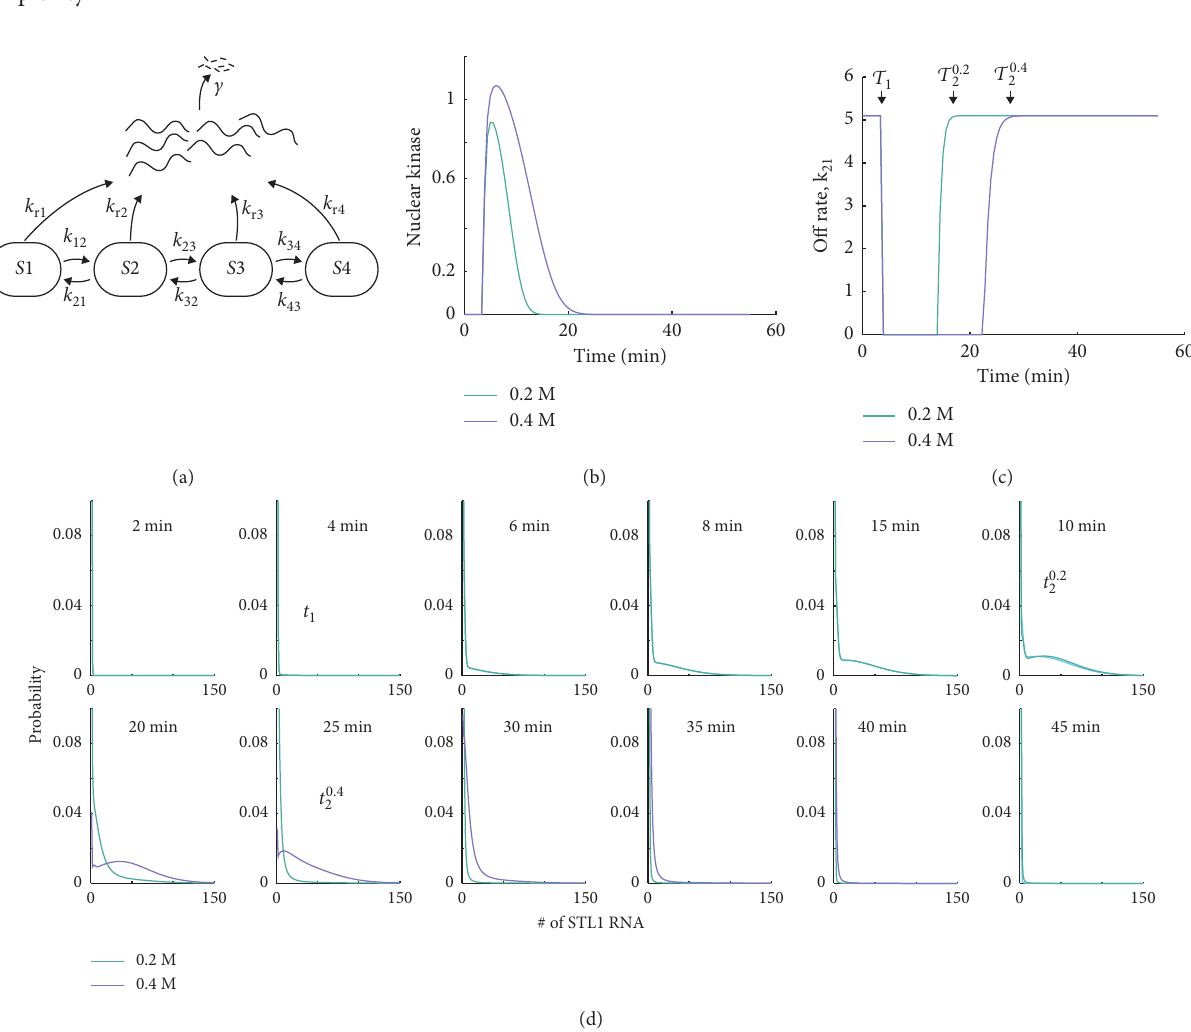
Figure 1: Stochastic modeling of osmotic stress response genes in yeast. (a) Four-state model of gene expression, where each state transcribes mRNA at a different transcription rate, but each mRNA degrades at a single rate c . (b) Time-varying MAPK nuclear localization signal. (c) The rate of switching from gene activation state S2 to S1 (right) under 0.2 M or 0.4 M NaCl osmotic stress. The time at which k 21 turns off is denoted with τ 1 and is independent of the NaCl level. The time at which k 23 turns back on is given by τ NaCl depending on the level of NaCl. (d) Time evolution of the STL1 mRNA in response to the 0.2M and 0.4M NaCl stress. Model and parameters from [10] are summarized in Supplementary Notes I and II and Supplementary Tables I and